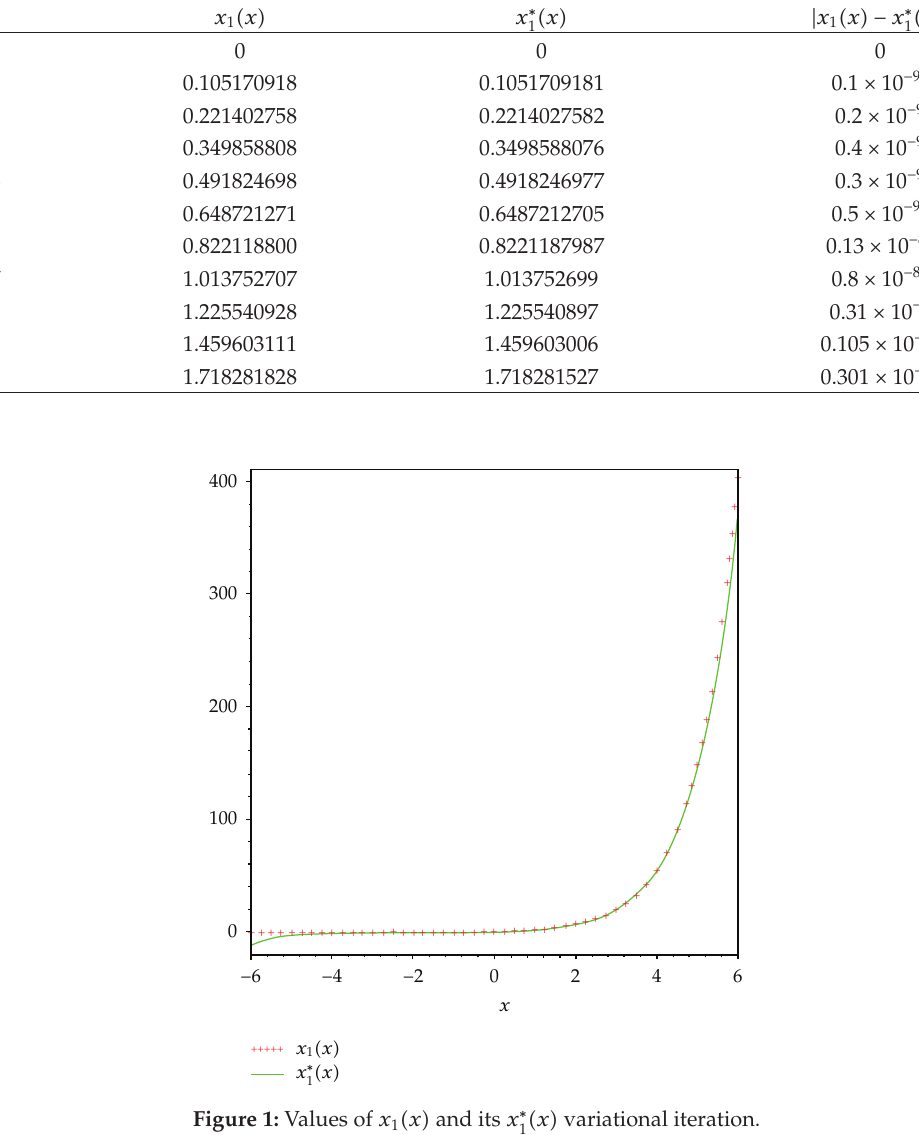
Table 1: Numerical solution of x 1 (cid:3) x (cid:4) .